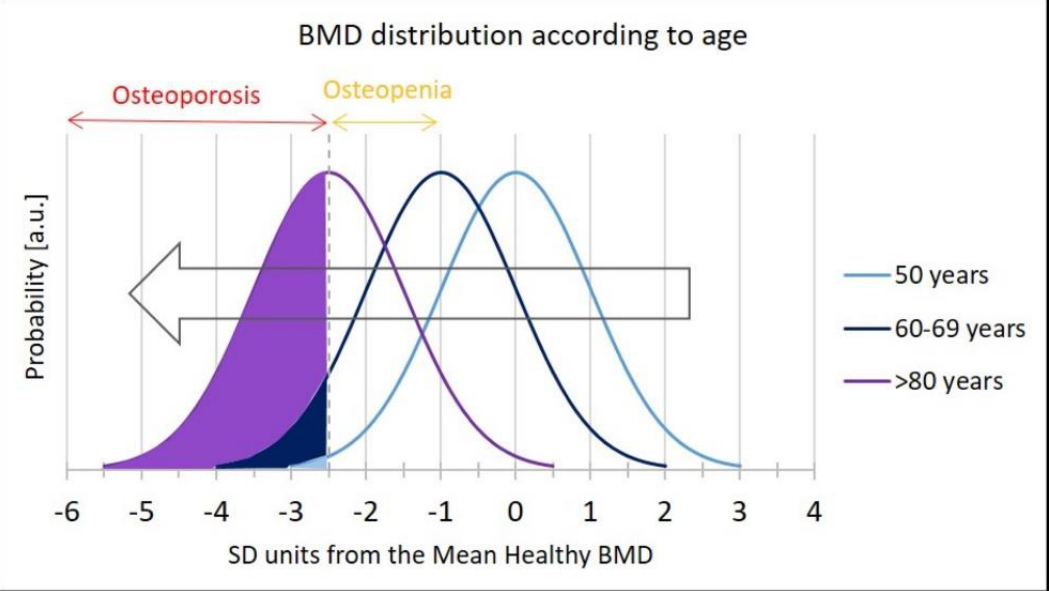
Figure 7. Bone mineral density (BMD) distribution in women at different ages. In purple is reported the area of osteoporosis prevalence according to WHO criteria. Legend: arbitrary unit (a.u.). Image adapted from Dimai et al. (reproduced with permission from [41], Elsevier, 2017).